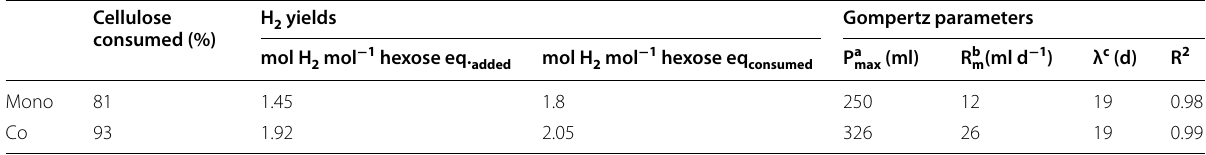
Table 2 H yields and Gompertz parameters of C. termitidis mono-cultured and co-cultured with C. beijerinckii on 2 g l − 1 2 cellulose